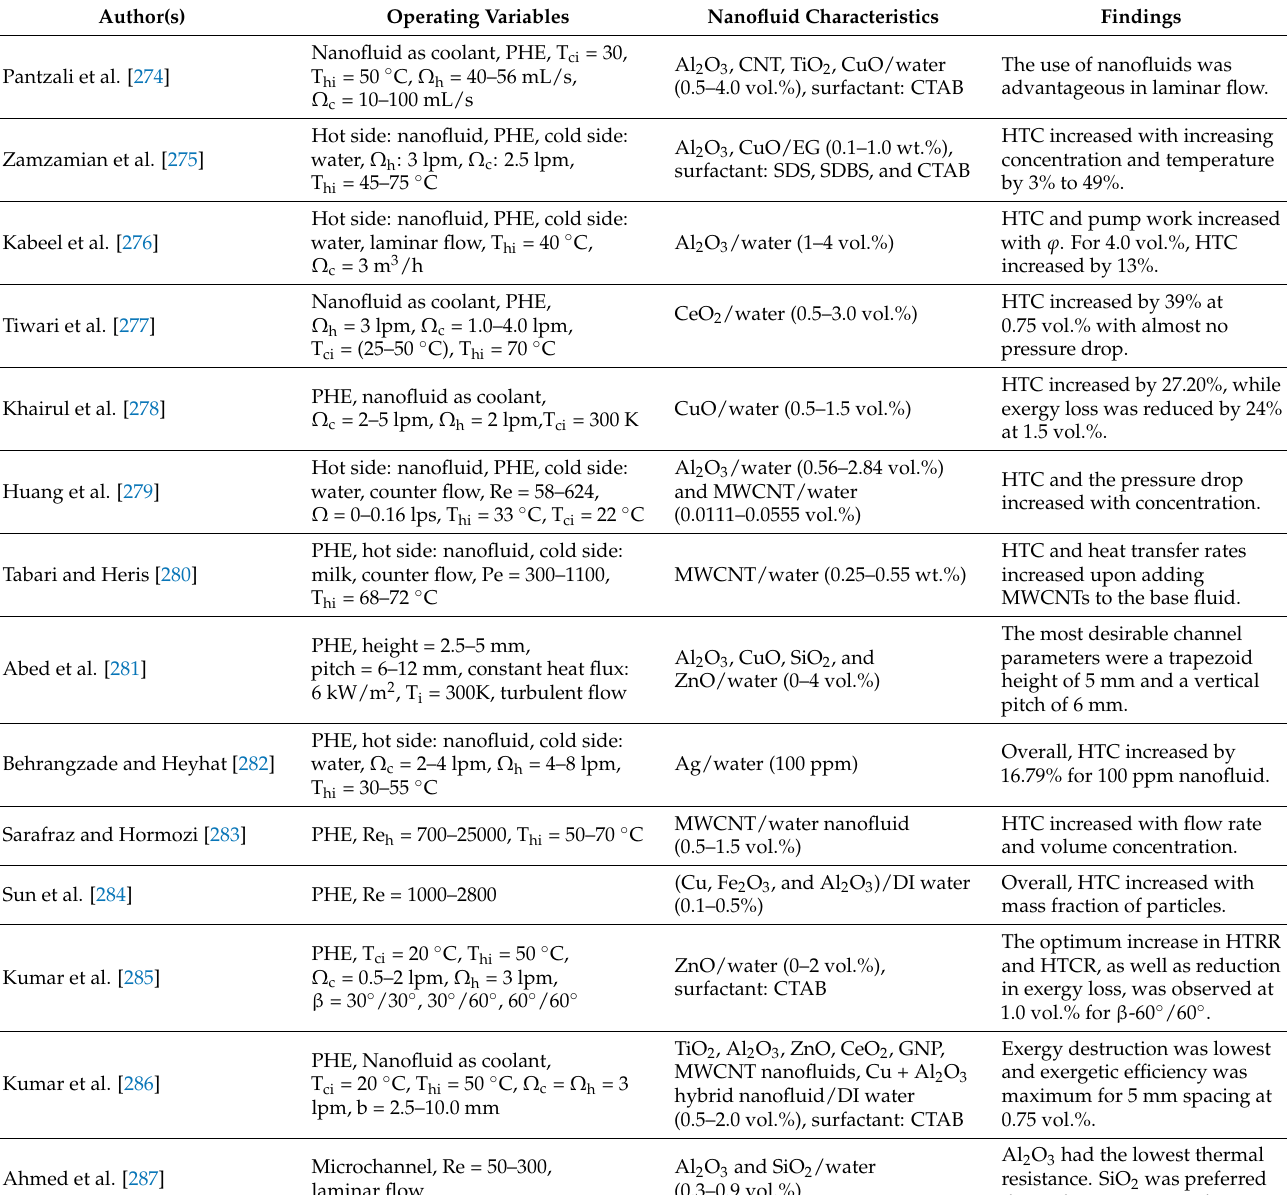
Table 7. Summary of studies on HEX with mono and hybrid